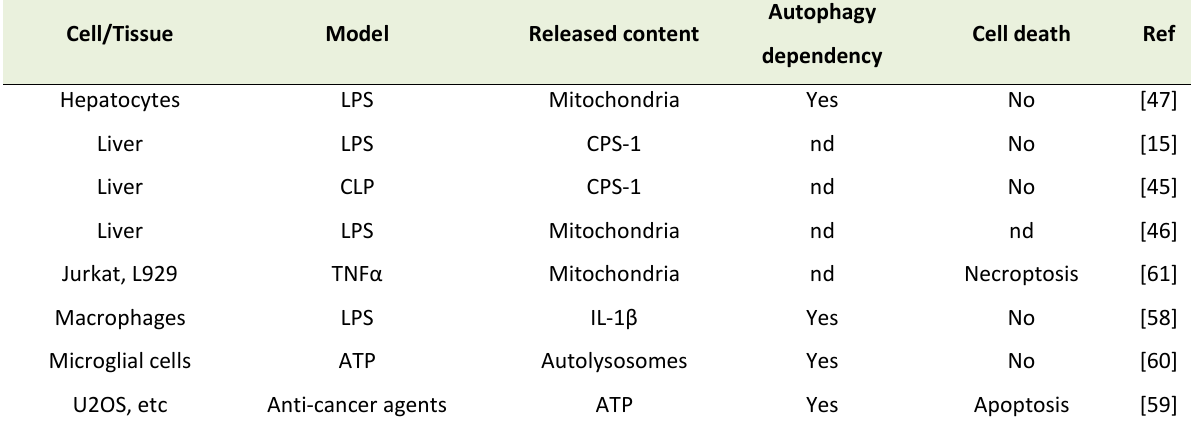
Table 2. Release of intracellular contents from